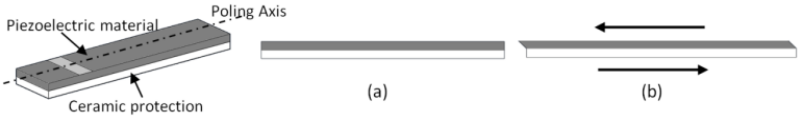
Figure 13. Schematics of the shear transducer. (a) Undeformed, (b) deformed.